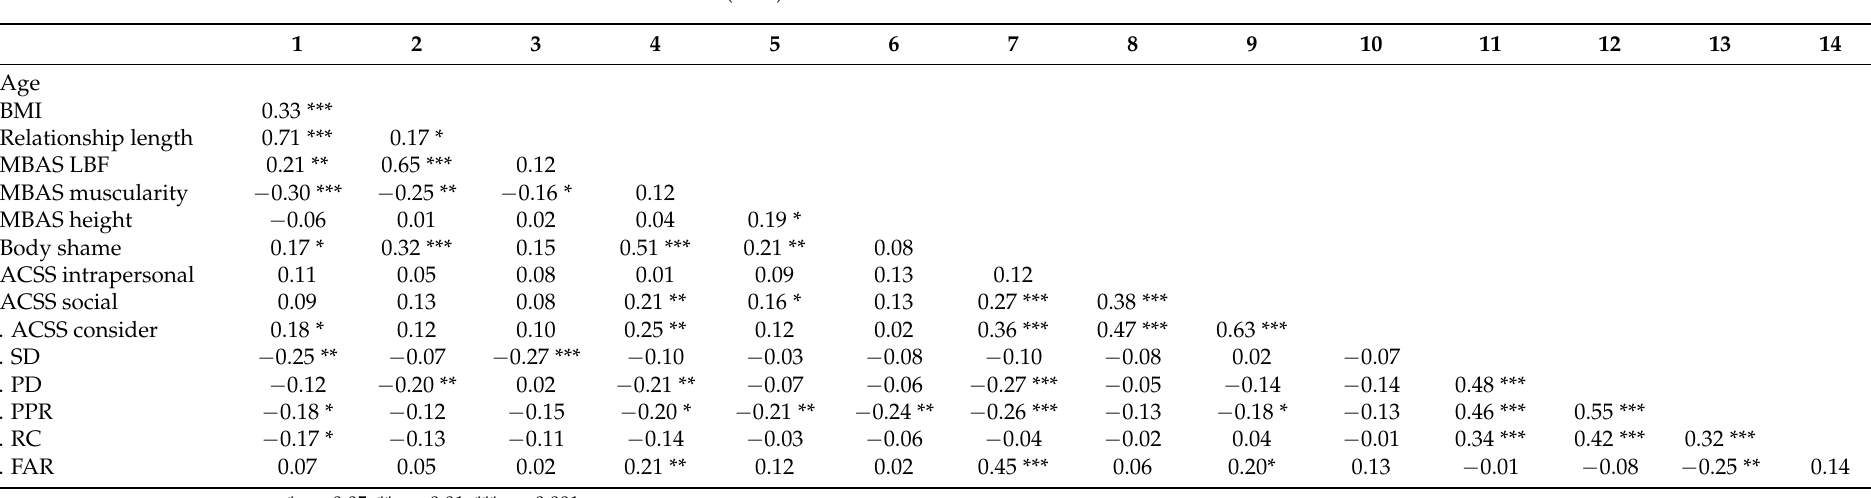
Table 3. Intercorrelations between variables (men).